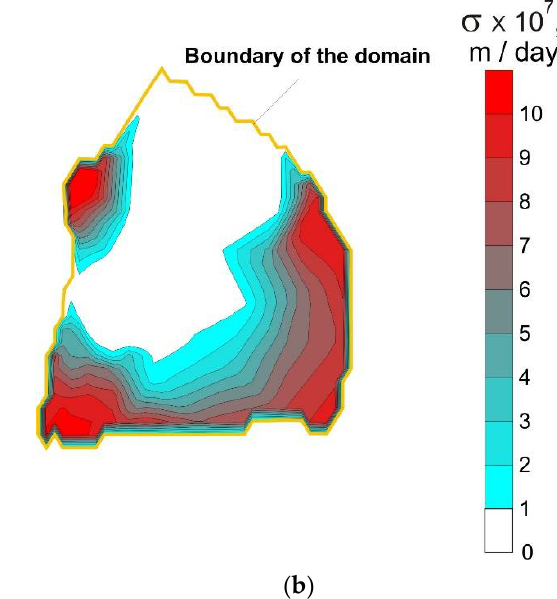
Figure 7. Distributions of W ( a ) and σ ( b ). Calculated values of W at the points of boreholes are equal exactly to measured values. A comparison of calculated and measured values of H 1 is presented in Table 1. Table 1. Comparison of calculated and measured values of hydraulic head in Horizon I in the points of boreholes.